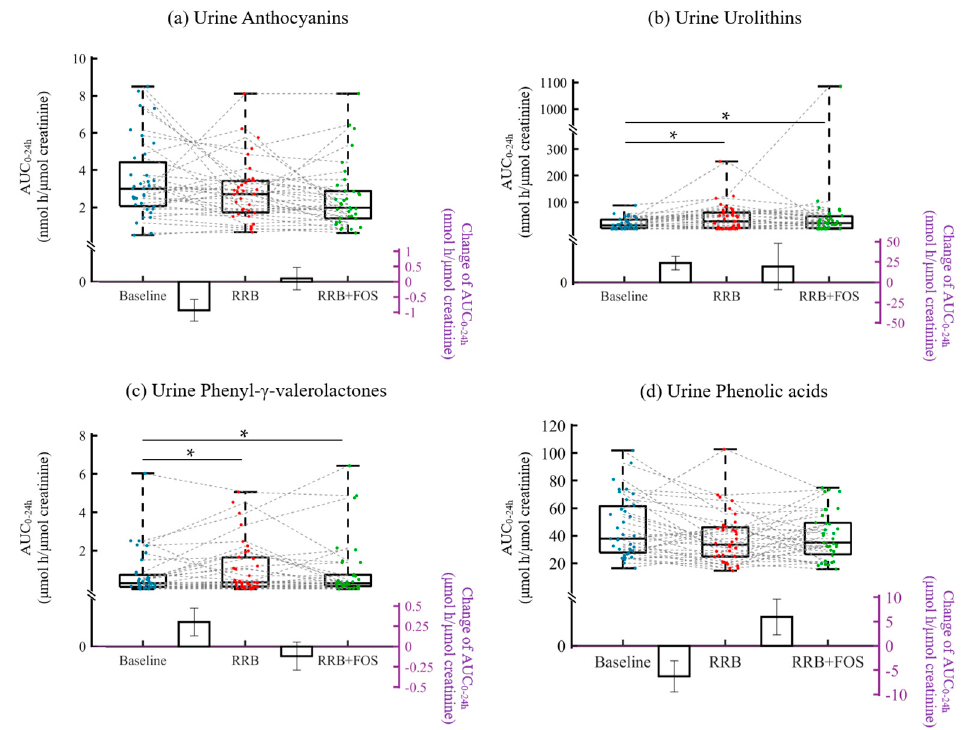
Figure 4. Urinary (poly)phenolic metabolites AUC 0–24h (areas under the 24-h curve) post-consumption of RRBtest drink at the baseline/week 0, after 4-week RRB and 4-week RRB+FOS supplementations: ( a ) total anthocyanin derivatives; ( b ) total urolithin derivatives; ( c ) total phenyl- γ -valerolactone derivatives; ( d ) total phenolic acid derivatives. * Significant supplementation effect, p < 0.05. The box and whisker plots illustrate the distribution of values for each study visit. The line in the middle of the box is plotted at the median, the inferior and superior limit of the box correspond to the 25 th and the 75 th percentiles, respectively. Bars represent mean change of AUC 0–24h at baseline vs. 4-week RRB and 4-week RRB vs. 4-week RRB+FOS, with their standard errors.